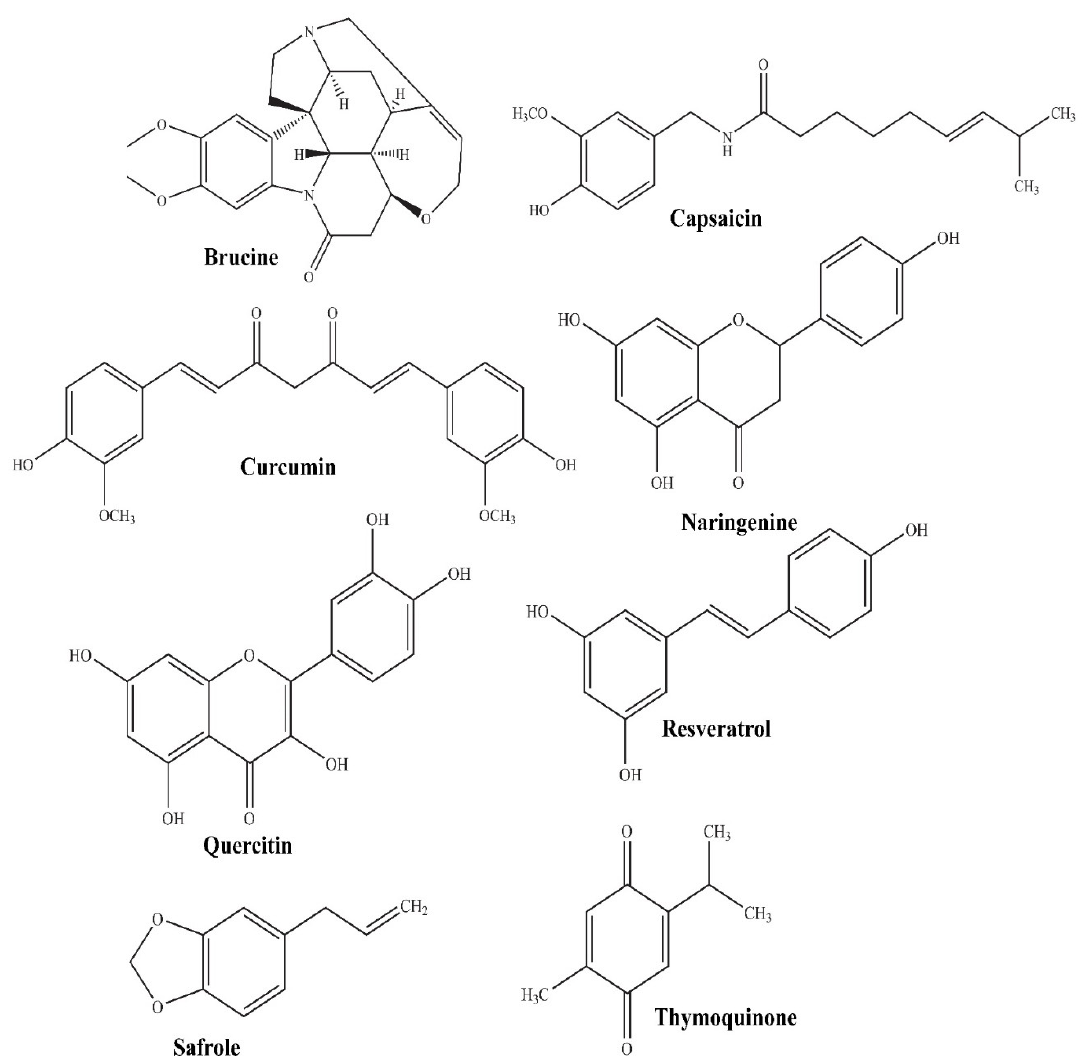
Figure 1. Molecular structure of some promising phytopharmaceuticals.